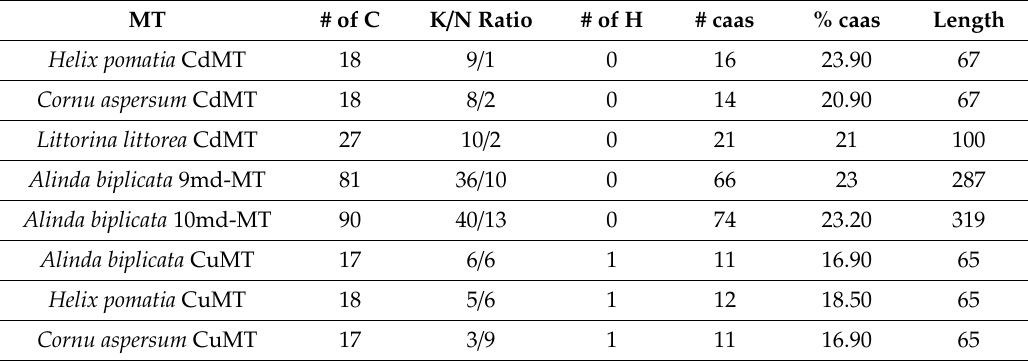
Table 1. Di ff erent gastropod species MTs (left column) with abundance of amino acid residues (in single-letter codes) that are supposed to influence the metal-specific binding character of the respective MT proteins. The abundance of the selected amino acids refers to confirmed Cd- and Cu-specific gastropod MTs and snail md-MTs. The number (#) of selected amino acids (C, K, N, H) and the percentage (%) of charged amino acids (caas) in relation to the whole amino acid length (last column) of the respective MT peptide sequences (including the M at the start position) are listed. GenBank